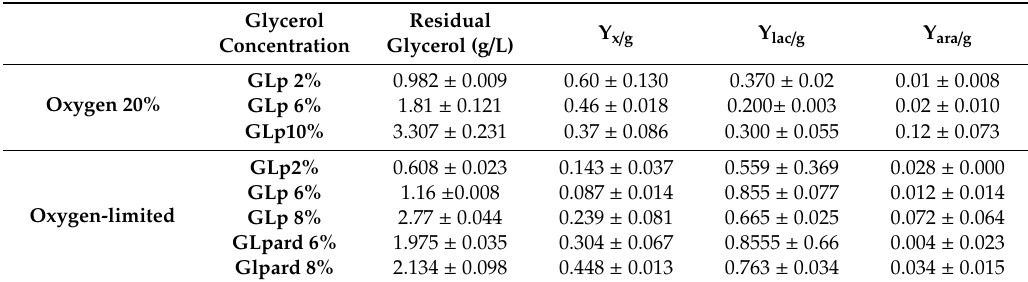
Figure 3. GLp batch aerobic culture on the accumulation of lactate and arabitol in di ff erent initial glycerol concentrations: 2%, 6%, and 10%, lactate (green) and arabitol (blue) production. All fermentations were with the GLp strain. The experiments were carried out in biological duplicates. Table 4. Batch fermentation of GLp and GLpard strain performed under di ff erent oxygenation and glycerol (g) concentrations. Yields (Y) of biomass (x), lactate (lac), and arabitol are given in C-mol / C-mol ± the deviation of the mean. Experiments were performed in biological